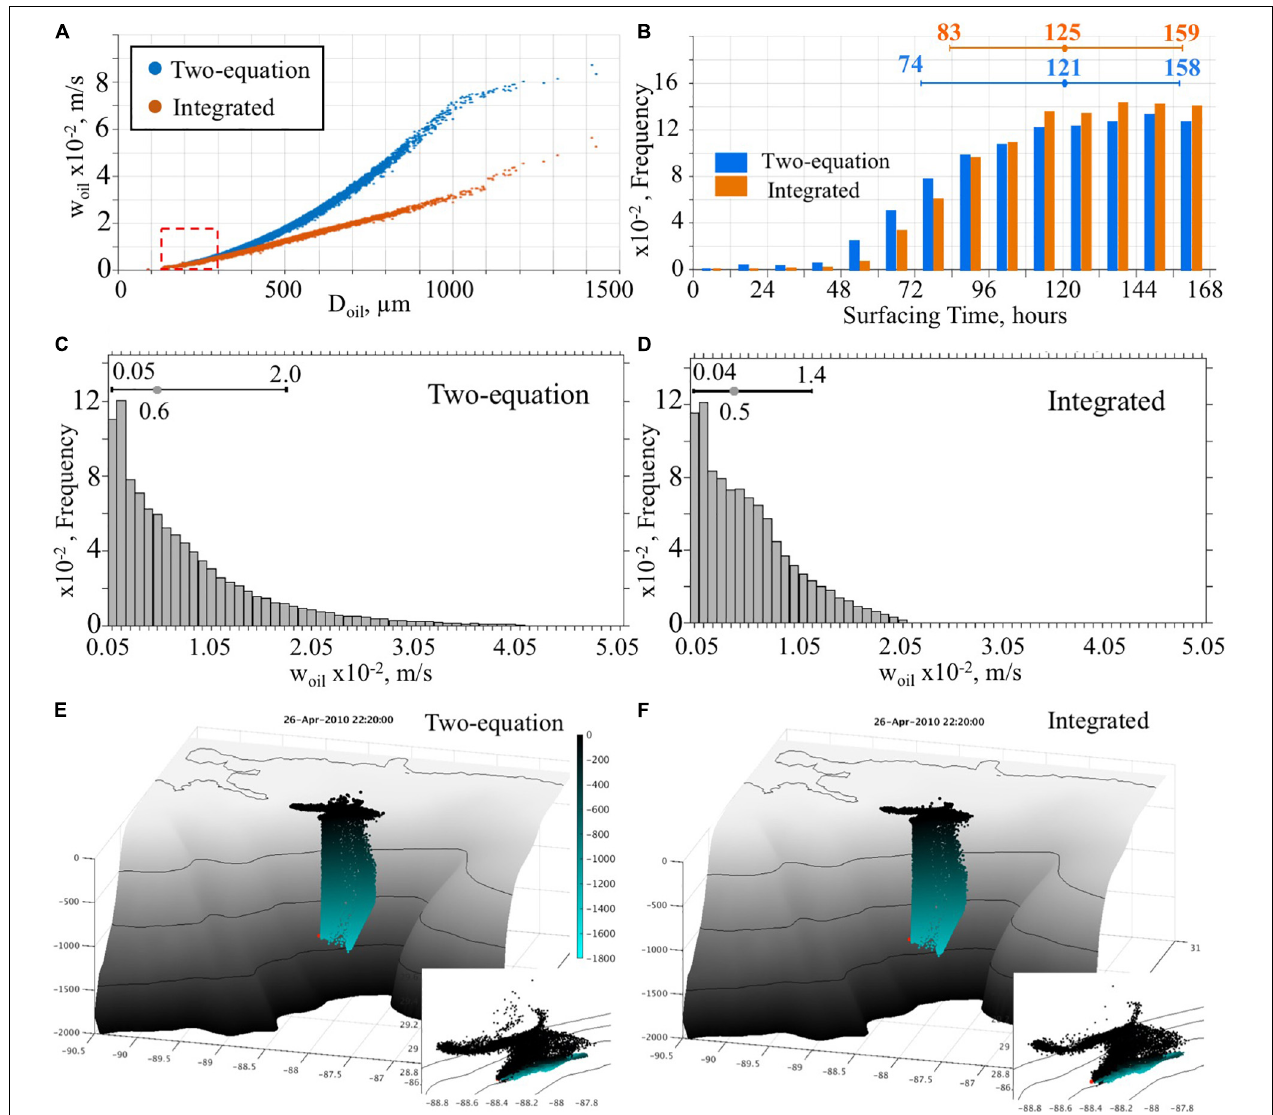
FIGURE 3 | (A) oil droplet vertical velocity vs. oil droplet size from OTWM simulations using two-equation and integrated algorithms of buoyant velocity. The red dashed box indicates the interdecile region for D oil from Figure 2A . (B) The surfacing time (hours after release) of oil droplets estimated from the 7 day test simulations with two algorithms for buoyant velocity. At the top, the median, 10th and 90th percentiles are presented. (C,D) Histograms showing w oil distribution in the OTWM simulations using two-equation (left) and integrated (right) algorithms of buoyant velocity. (E,F) 3-dimensional distribution of the Lagrangian floats in the water column in the OTWM simulations using different formulations of buoyant velocities after 7 days of the simulation. The insets show the float positions projected onto the sea surface plane. Colors designate particles’ depth in the water